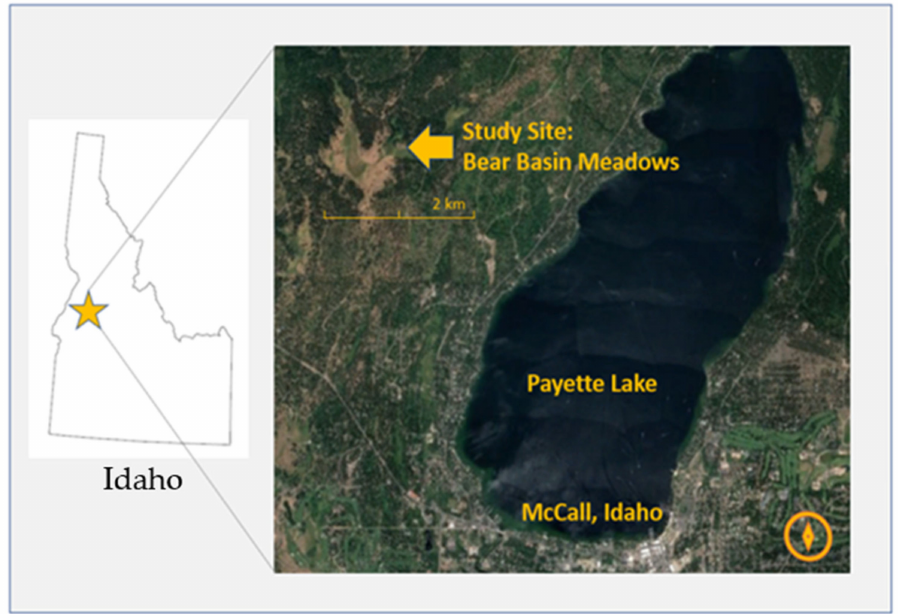
Figure 2. Study site location: Bear Basin Meadows, Payette National Forest, McCall Ranger District, Idaho. Fourteen snow-free trees of varying size classes (maximum height = 31.7 m; minimum height = 1.4 m; mean height = 11.7 m; standard deviation = 9.6 m) and structural forms (e.g., maximum width = 13.9 m; minimum width = 2.6 m; mean width = 8.1 m; standard deviation = 3.3 m) were scanned with a Leica Scan Station 2 (Leica Geosystems AG Heer- brugg, Switzerland) TLS (distance accuracy ± 4 mm with 0.15 mrad beam divergence) on October 25, 2018. Trees ( Pseudotsuga menziesii (n = 2), Pinus contorta (n = 10), Pinus ponderosa (n = 2)) were visually selected to represent variance in structure (e.g., canopy height,